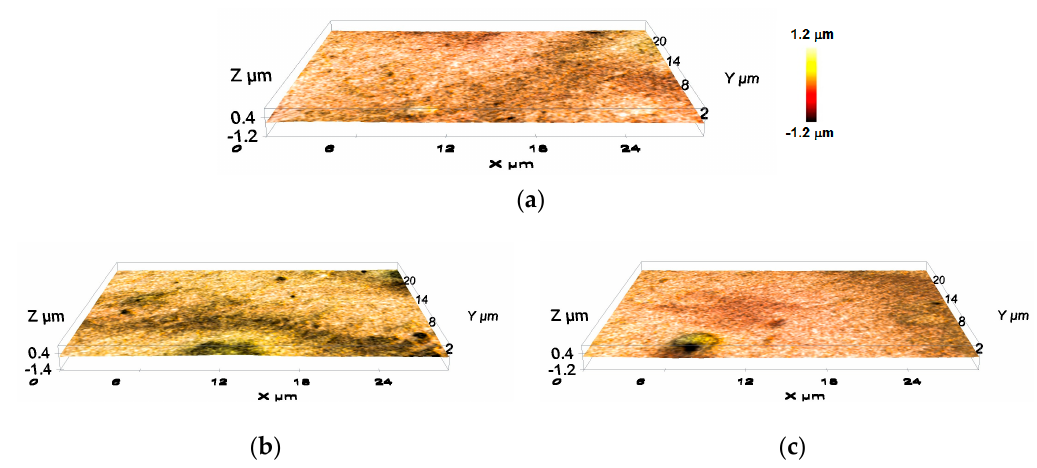
Figure 12. Surface topographies of the PU films treated by plasma (180 s) in gas mixtures with a concentration of 50% of each gas: ( a ) N 2 /O 2 , ( b ) Ar/O 2 , and ( c ) N 2 /Ar.